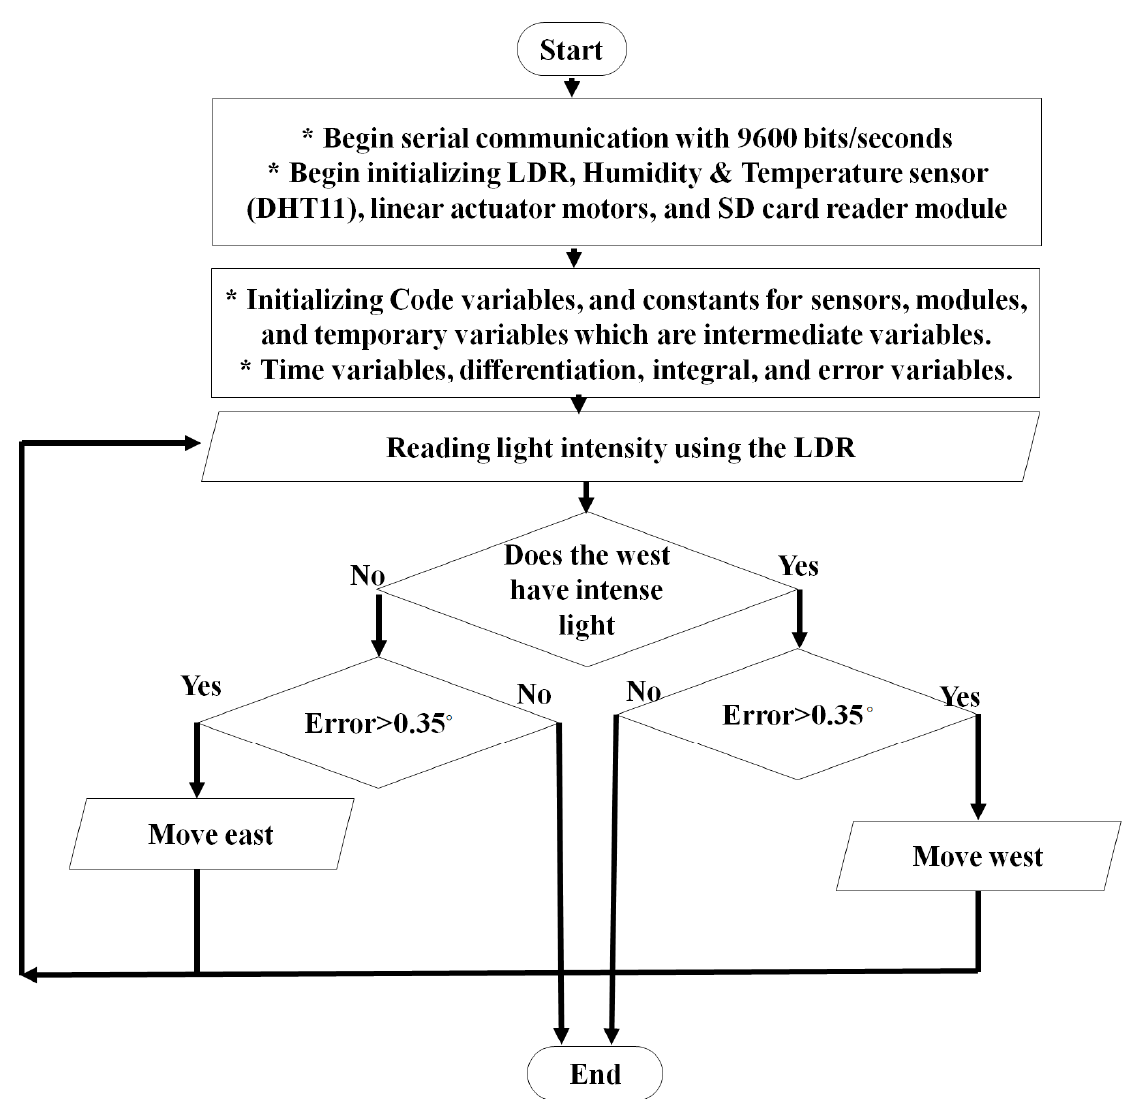
Figure 7. Flow chart algorithm operation for sensor-based SAST.